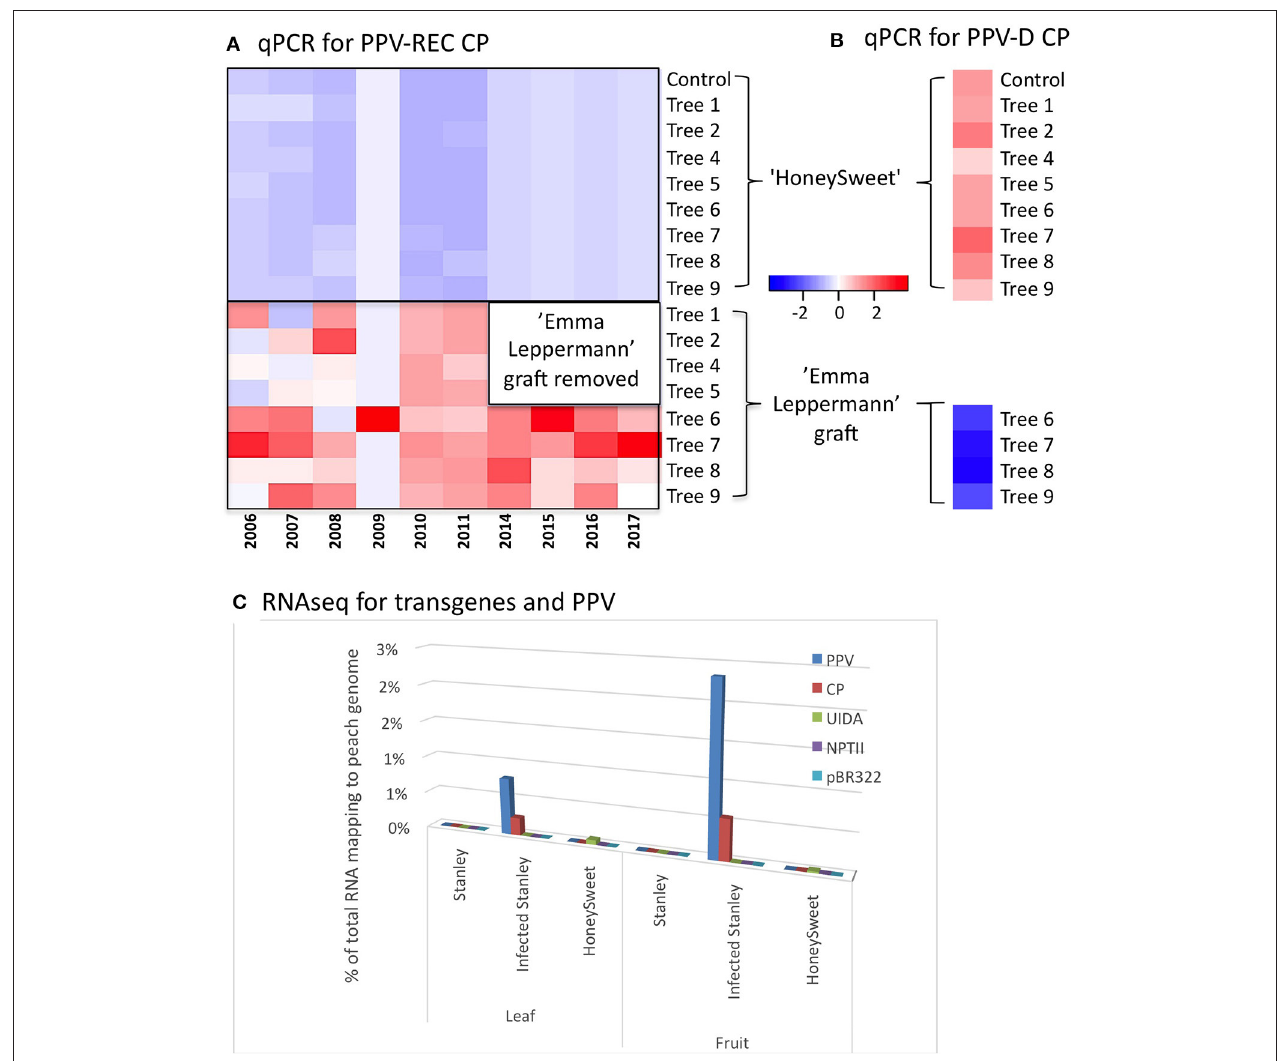
FIGURE 1 | The presence or absence of PPV and expression of the transgenes in ‘HoneySweet’ and comparators, PPV-REC-infected ‘Emma Leppermann’ and ‘Stanley’ infected or not was determined by qPCR analyses for the graft-challenged material and using RNA-Seq studies for the multi-location trial. Heatmaps (A, B) showing the relative abundance of CP RNA in ‘HoneySweet’ trees and grafted and artificially infected ‘Emma Leppermann’ limbs. ‘HoneySweet’ contains a CP transgene derived from the PPV-D serotype and ‘Emma Lepperman’ was infected with a PPV-REC serotype (originating from Bulgarian). (A) Leaves from eight ‘HoneySweet’ trees and their associated grafts (infected ‘Emma Leppermann’) were sampled together with a control ‘HoneySweet’ tree with no graft, for the presence of CP RNA from PPV-REC each year using qPCR with serotype-specific primers, REC-J-F and REC-J-R. (B) Transgene PPV-D was quantified in the same eight ‘HoneySweet’ trees and associated grafts in four of the trees and the control ‘HoneySweet’ with no graft, for 1 year utilizing serotype-specific primers, PPV-FD and PPV-RR. Heatmaps were drawn from log-transformed (log2) using the ggplots package of the R-statistical software. Color key represents the scale distribution of the expression/abundance. The PPV-REC CP RNA was only detected in ‘Emma Leppermann’ and the PPV-D CP RNA was only detected in ‘HoneySweet’ leaves. (C) Amount of RNA homologous to the transgenes contained in ‘HoneySweet’ and the PPV genome, as a percentage of the total reads that map to the peach